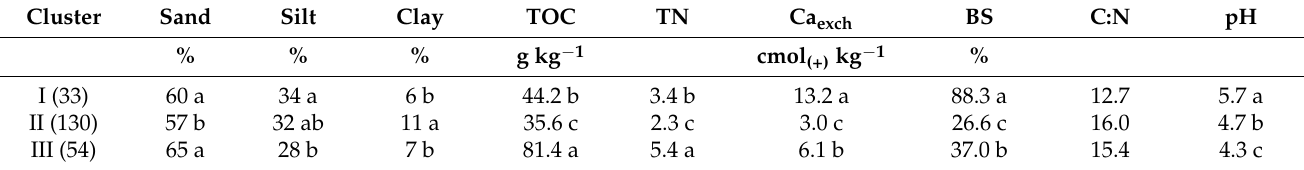
Table 6. Mean of sand, silt, clay, total organic carbon (TOC), total nitrogen (TN), and exchangeable Ca (Ca exch ) contents, and BS, TOC–to–TN ratio (C:N), and pH values of the clusters obtained via cluster analysis on the set of data for the 1000 m above sea level altitudinal range. Within each column, values sharing similar letters do not indicate significant differences (Kruskal–Wallis test, p < 0.05).